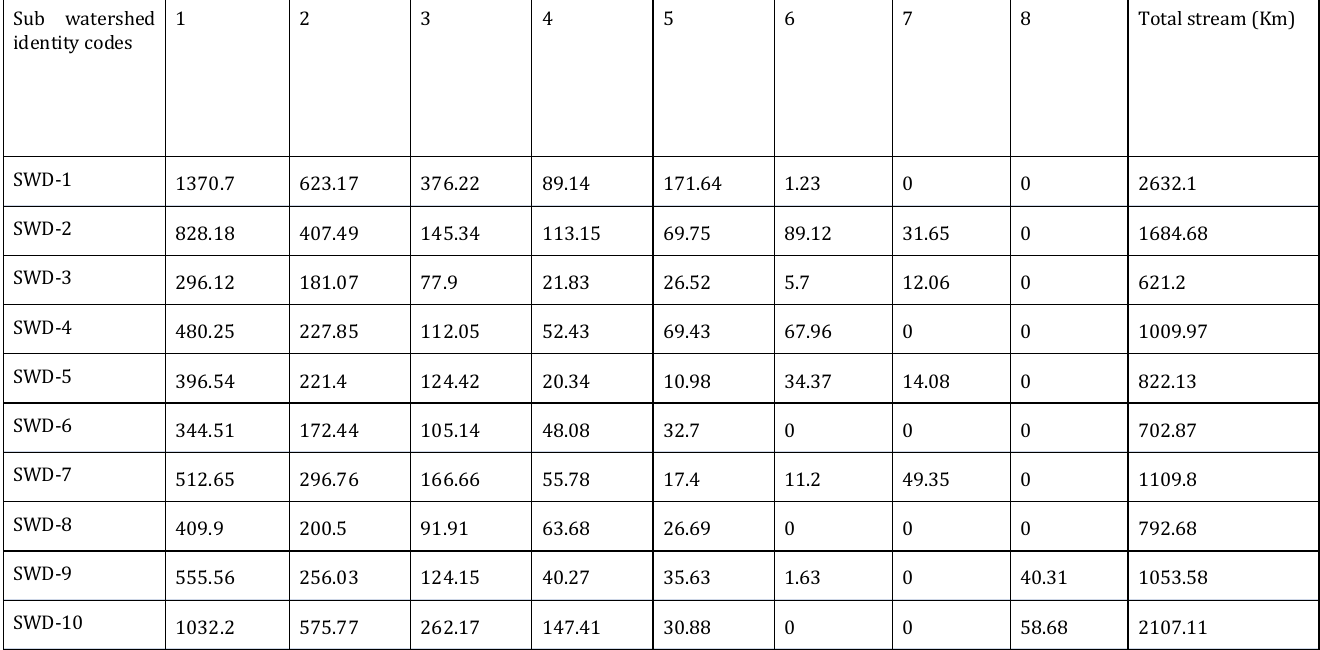
Table 5: Order wise total stream length